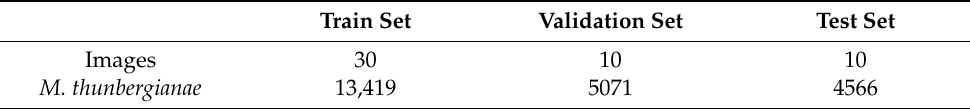
Table 1. Number of images and M. thunbergianae of